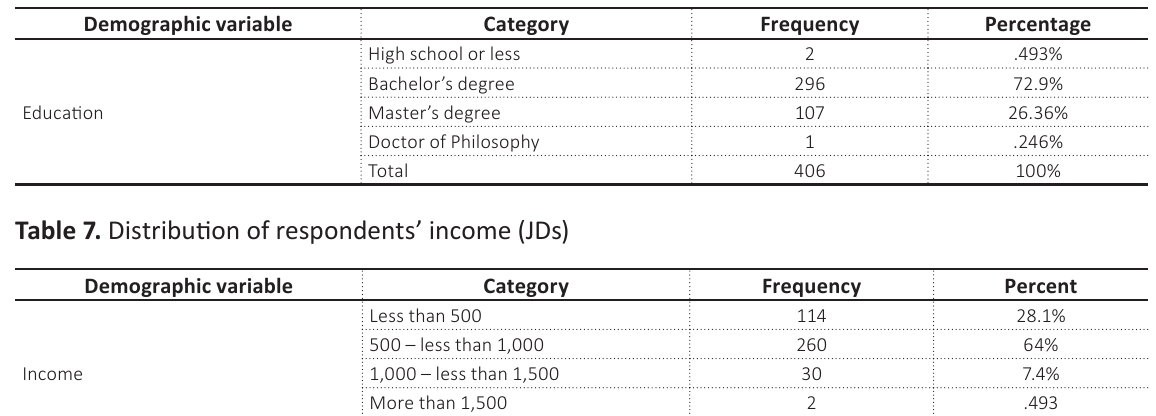
Table 6. Distribution of respondents’ educational level